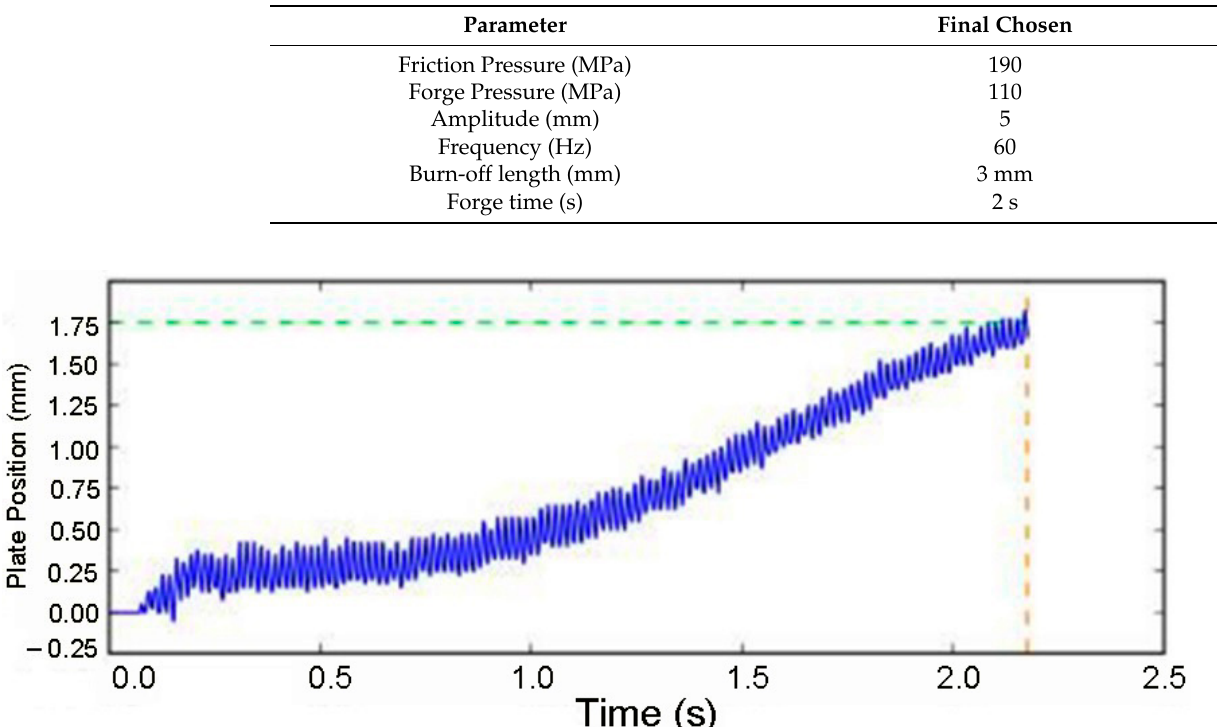
Figure 3. Loss of length in the base plates in the form of a flash in a typical weld